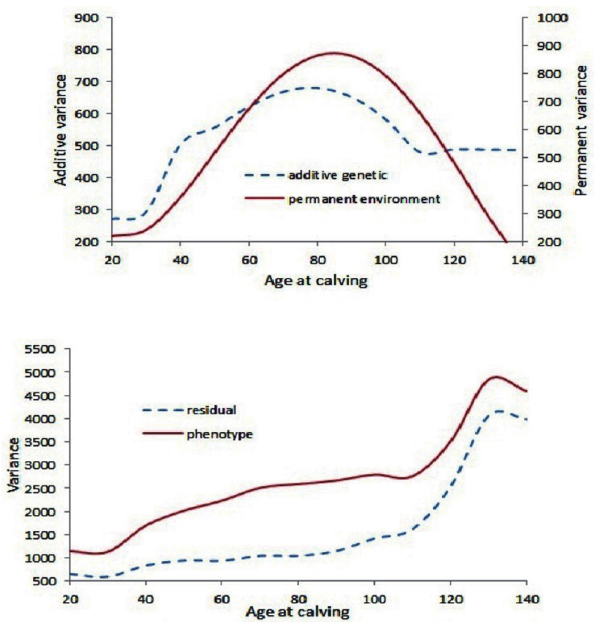
Figure 1. Additive genetic, permanent environmental, phenotypic and residual variances (/1,000) estimates for total milk 305-day with the best random regression model fitted (LE33het10).